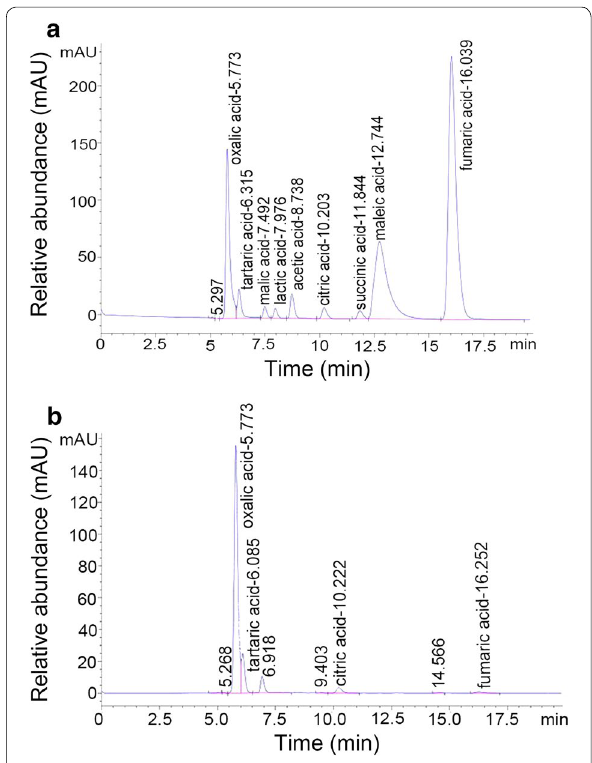
Fig. 2 Analyses of organic acids secreted by CS-1 strain were performed by HPLC. HPLC analysis of organic acids. a Chromatogram of a standard solution containing the following organic acids: oxalic, tartaric, malic, lactic acid, acetic, citric, succinic, maleic, and fumaric acid. b Chromatogram of a 3-day-old culture medium inoculated with strain CS-1, mainly containing oxalic, tartaric, and citric